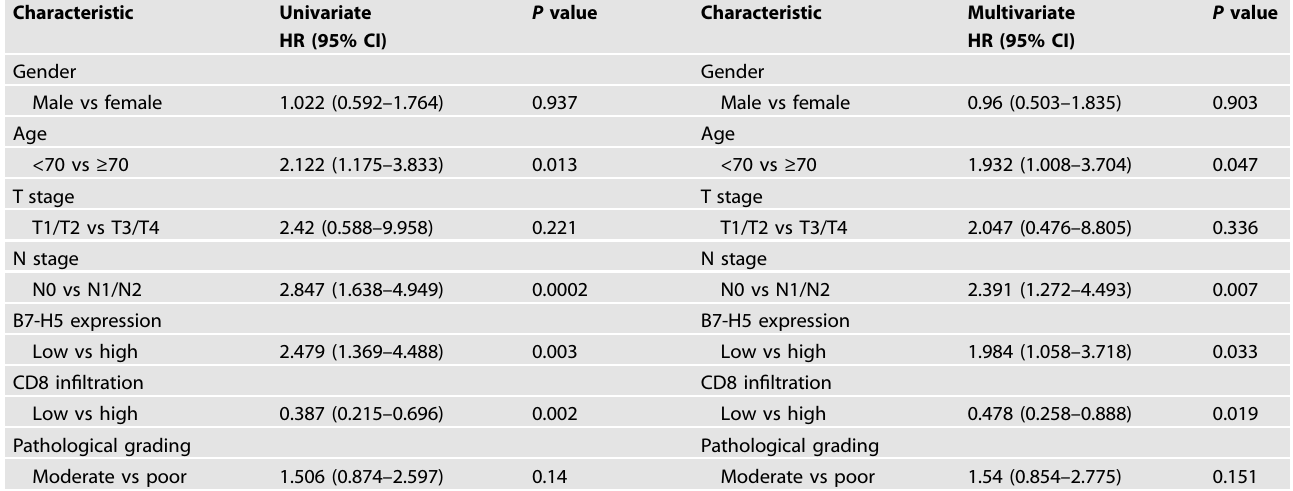
Table 2. Univariate and multivariate analysis of overall